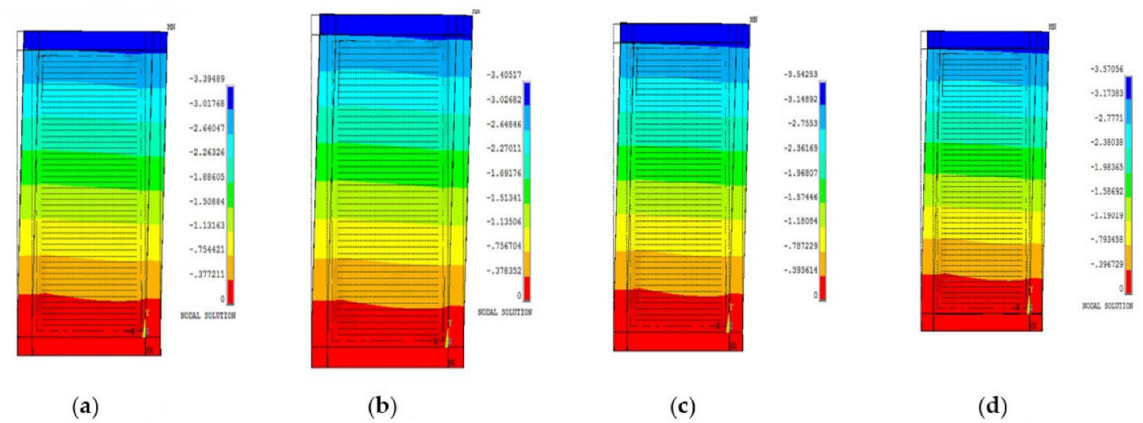
Figure 9. Effect of reinforcement ratio (RR) on the lateral displacement, ( a ) RR = 1%, ( b ) RR = 1.5%, ( c ) RR = 2.5%, ( d ) RR = 3.5%